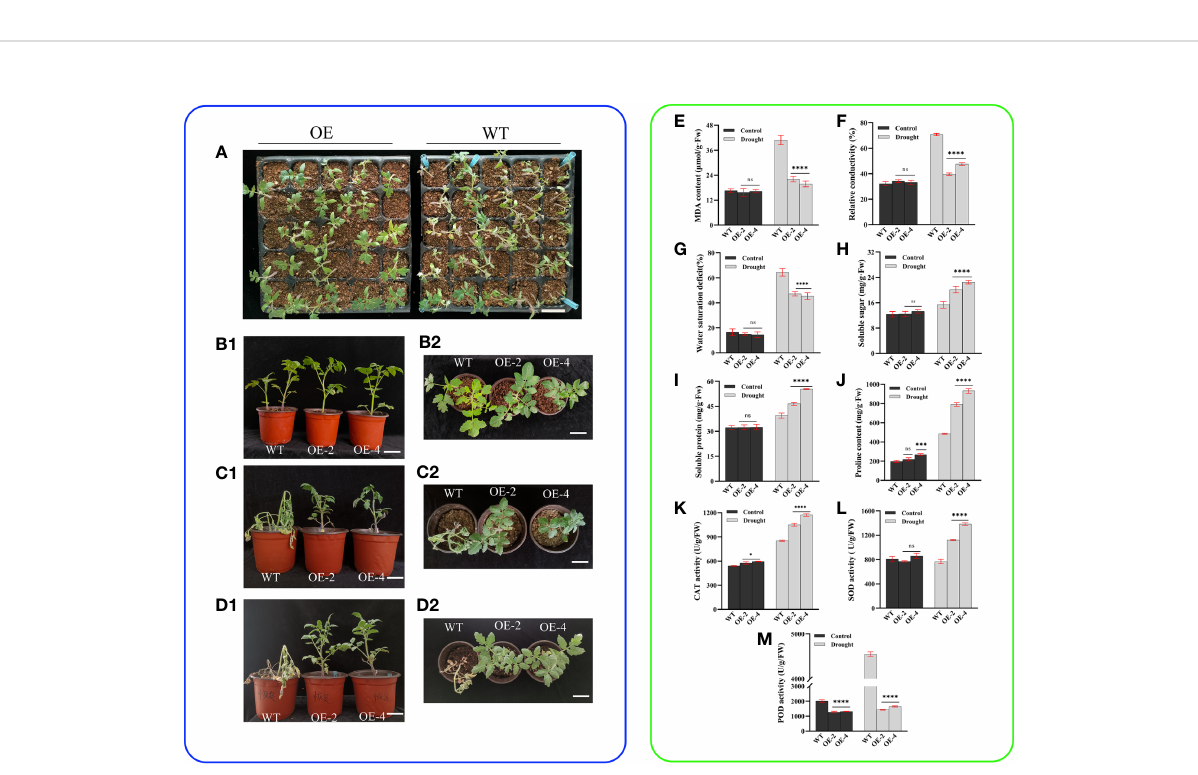
FIGURE 3 Phenotypic and physiological data of wild-type and transgenic tomatoes under drought stress. (A) The overall growth of wild type and transgenic tomatoes seedling trays under drought stress for 7 days. (B1) (Main view) and (B2) (top view) Growth status of wild-type and transgenic tomatoes at 4 weeks of age after normal watering. (C1) (Main view) and (C2) (top view): Morphological differences of 4 weeks tomatoes under drought stress for 16 days. (D1) (Main view) and (D2) (top view): The growth status of C1or C2 after 7 days of rehydration. (E) MDA content. (F) Relative conductivity content. (G) Water saturation de fi cit. (H) Soluble sugar content. (I) soluble protein content. (J) Proline content. (K) CAT activity. (L) SOD activity. (M) POD activity. Data are means ± SD of three replicates. (7.2 cm inner diameter, 11.5 cm high). (Ns > 0.05, *P < 0.05, ***P < 0.001, and ****P < 0.0001 for comparisons between the transgenic lines and wild-type plants by Student ’ s t-tests).